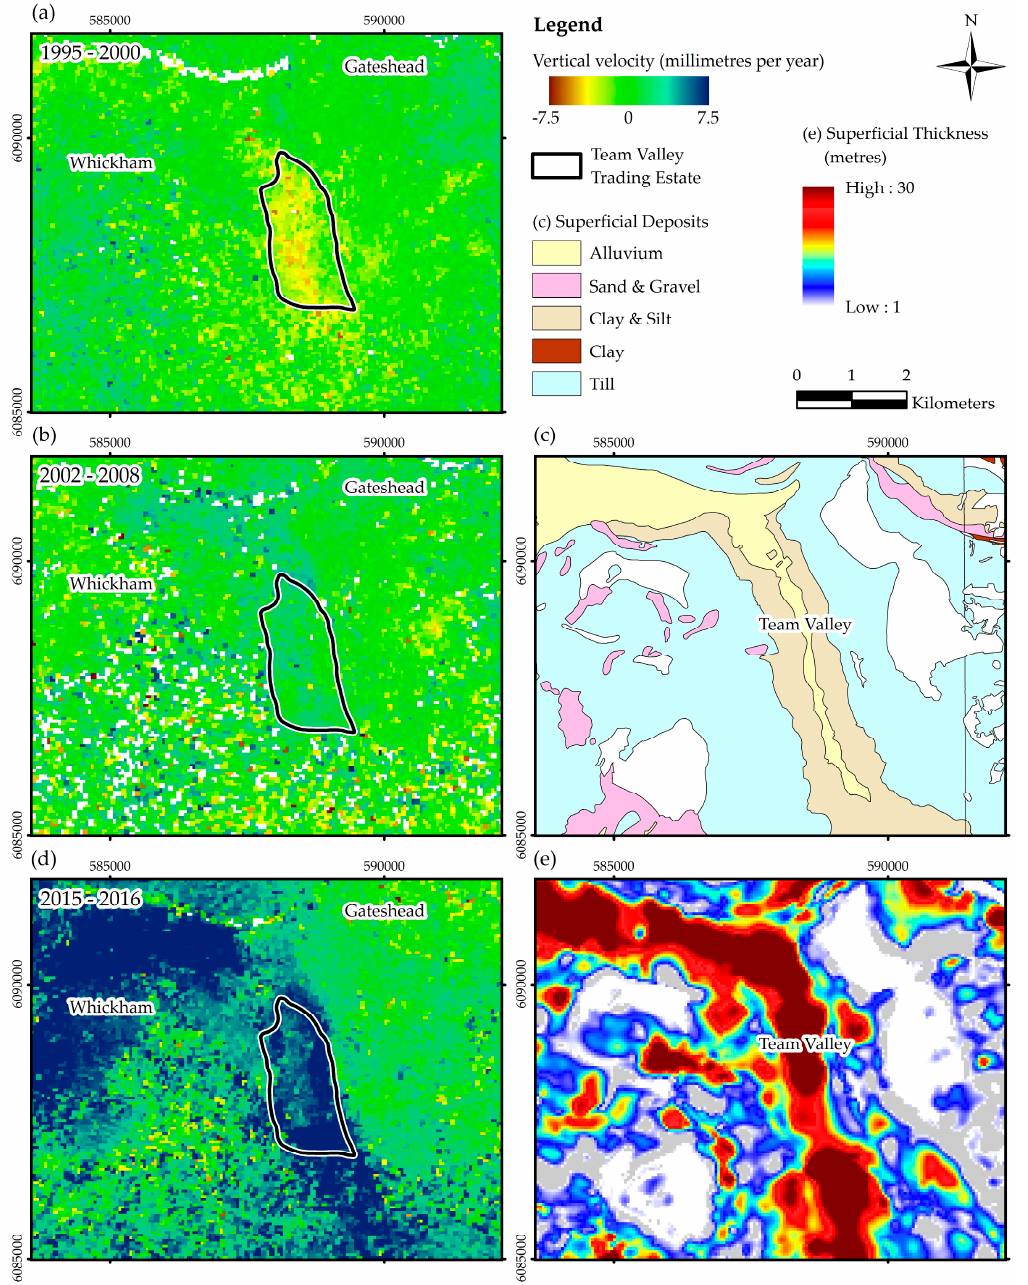
Figure 6. ( a ) ERS ISBAS vertical velocities (millimetres per year); ( b ) ENVISAT ISBAS vertical velocities (millimetres per year); ( c ) Superficial geology; ( d ) Sentinel-1 ISBAS vertical velocities (millimetres per year); ( e ) Superficial thickness. ‘Reproduced with the permission of the British Geological Survey ©NERC. All rights